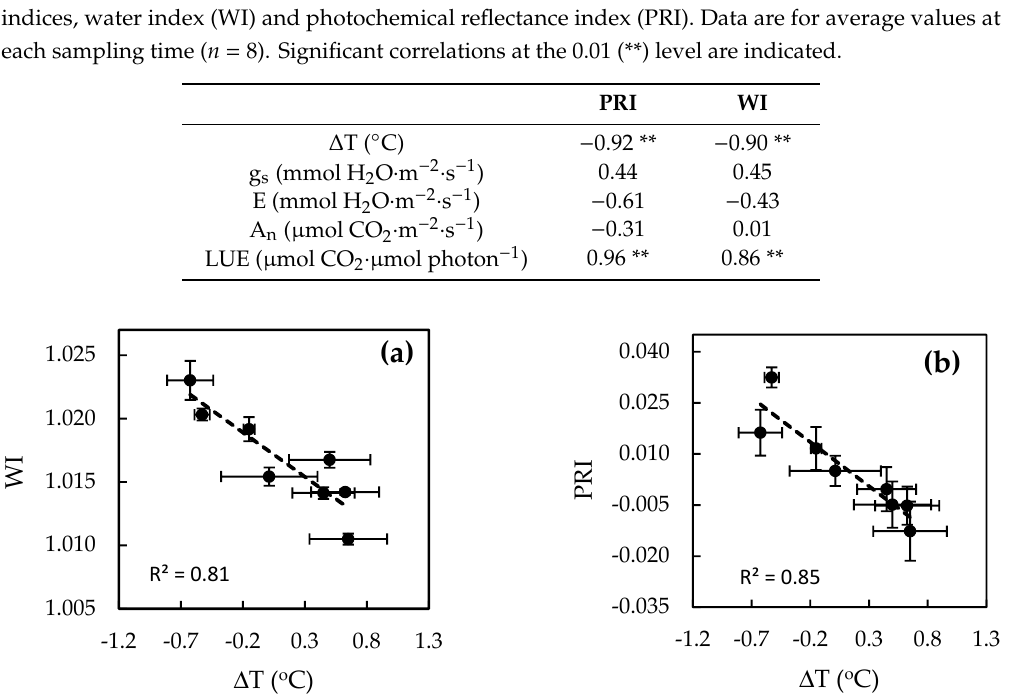
Figure 2. Relationship between the leaf-to-air temperature difference ( Δ T) measured at the leaf level in Xarel·lo potted plants with ( a ) water index (WI) and ( b ) photochemical reflectance index (PRI). Values are the means ± standard errors of the mean ( n = 8) measured at different hours throughout the day.